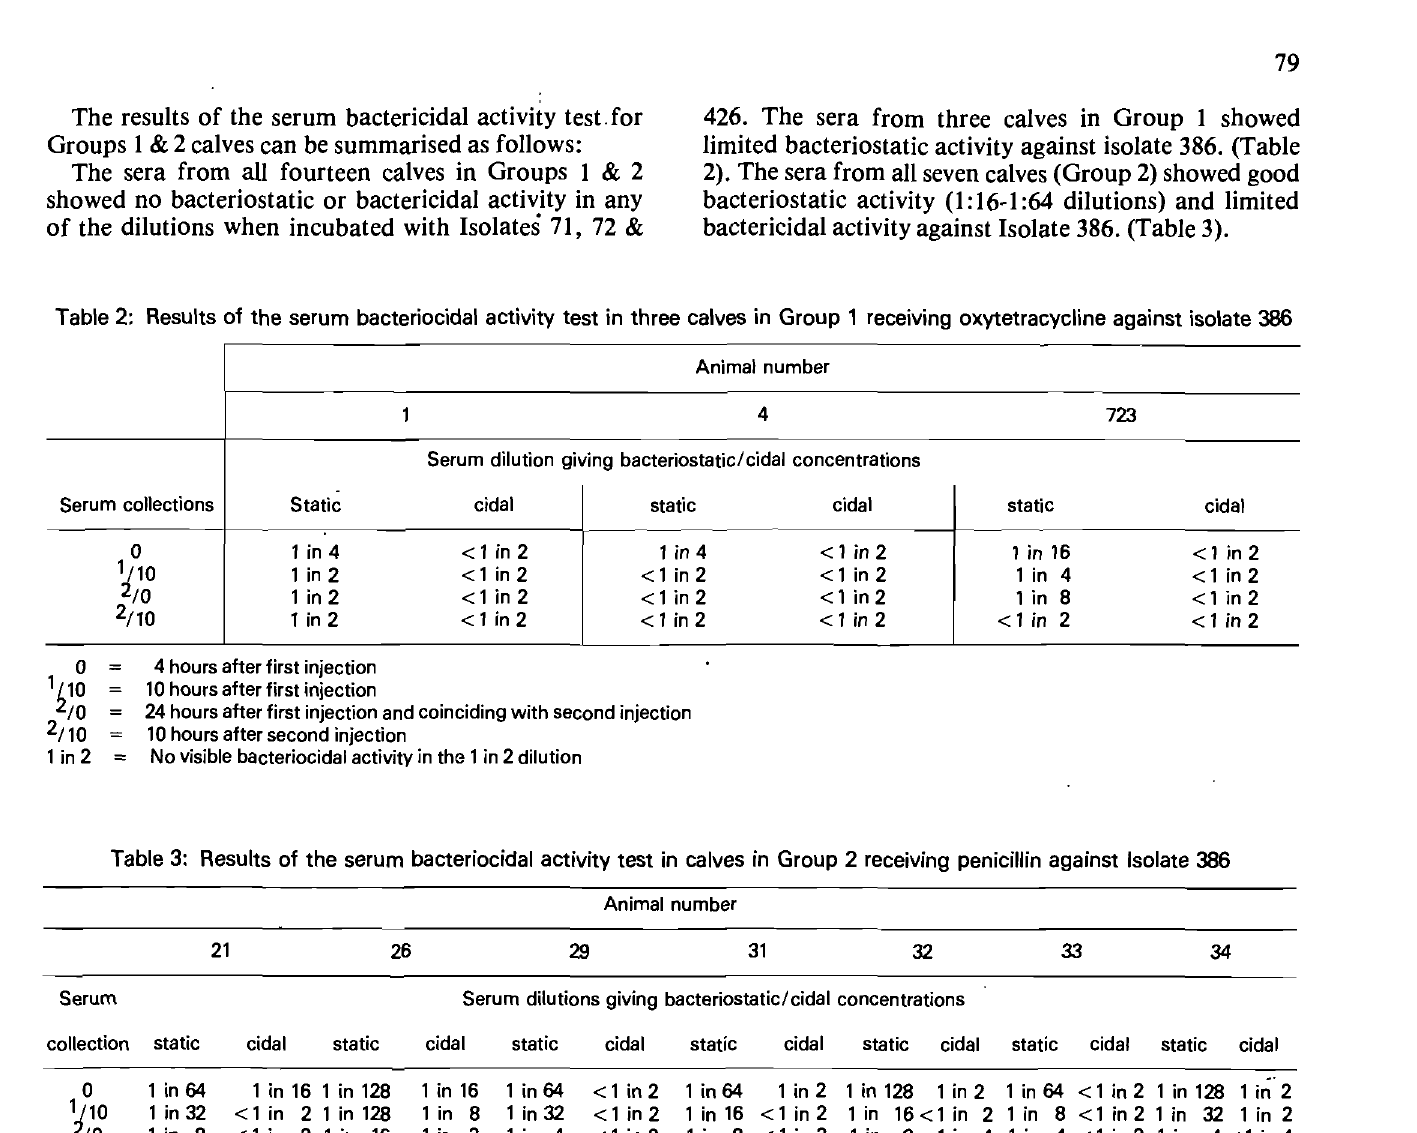
Table 3: Results of the serum bacteriocidal activity test in calves in Group 2 receiving penicillin against Isolate 386 Animal number